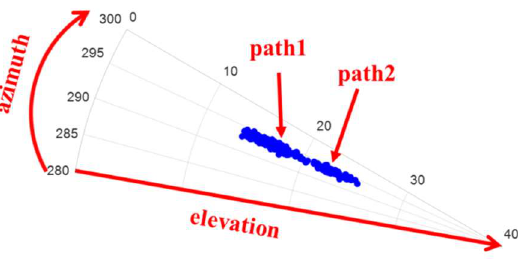
Figure 17. Local amplification of signal directions.